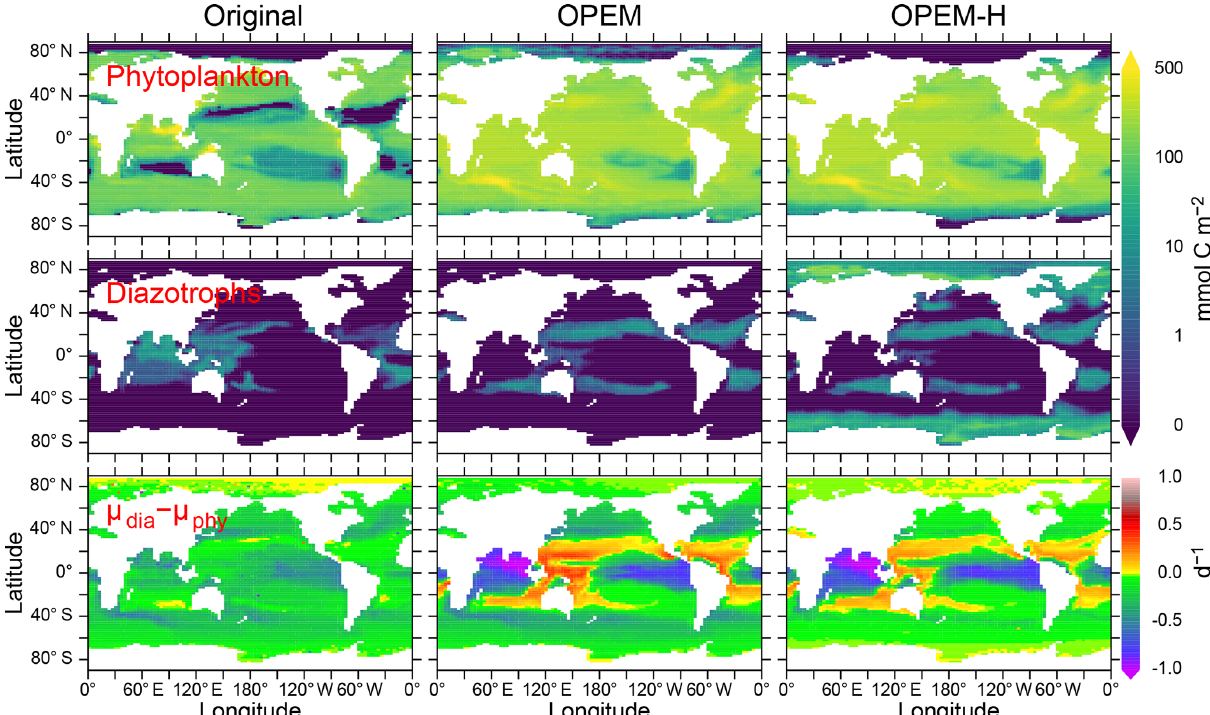
Figure 15. Vertically integrated and temporally averaged phytoplankton (top) and diazotroph biomass (centre) and difference between dia- zotroph and phytoplankton net relative growth rates (bottom), in the original, OPEM, and OPEM-H UVic simulations. Note that the positive growth-rate differences for the original UVic in the Arctic are spurious as they result from µ dia = 0d − 1 and µ phy < 0d − 1 .